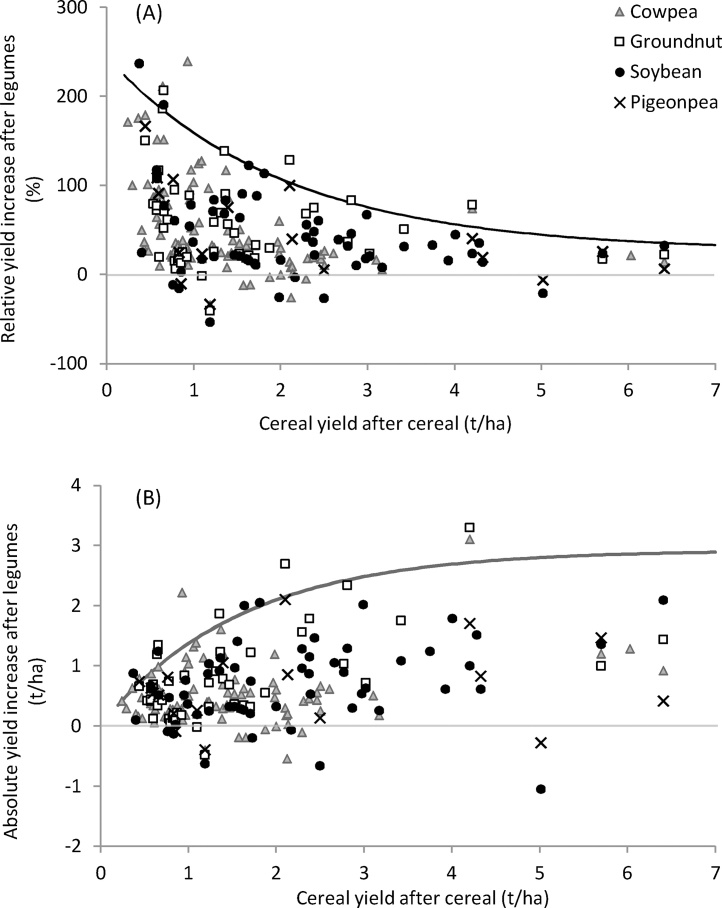
Relative (A) and absolute (B) grain yield increase of cereal after different types of legumes, relative to the yield of continuous cereal, plotted against continuous cereal grain yield. The curved lines indicate the upper boundary of maximum yield increases.